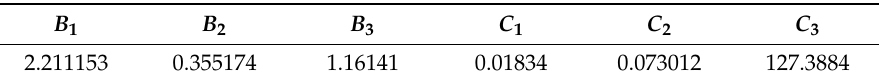
Table 2. Sellmeier’s equation coefficients for PBG-08A glass.